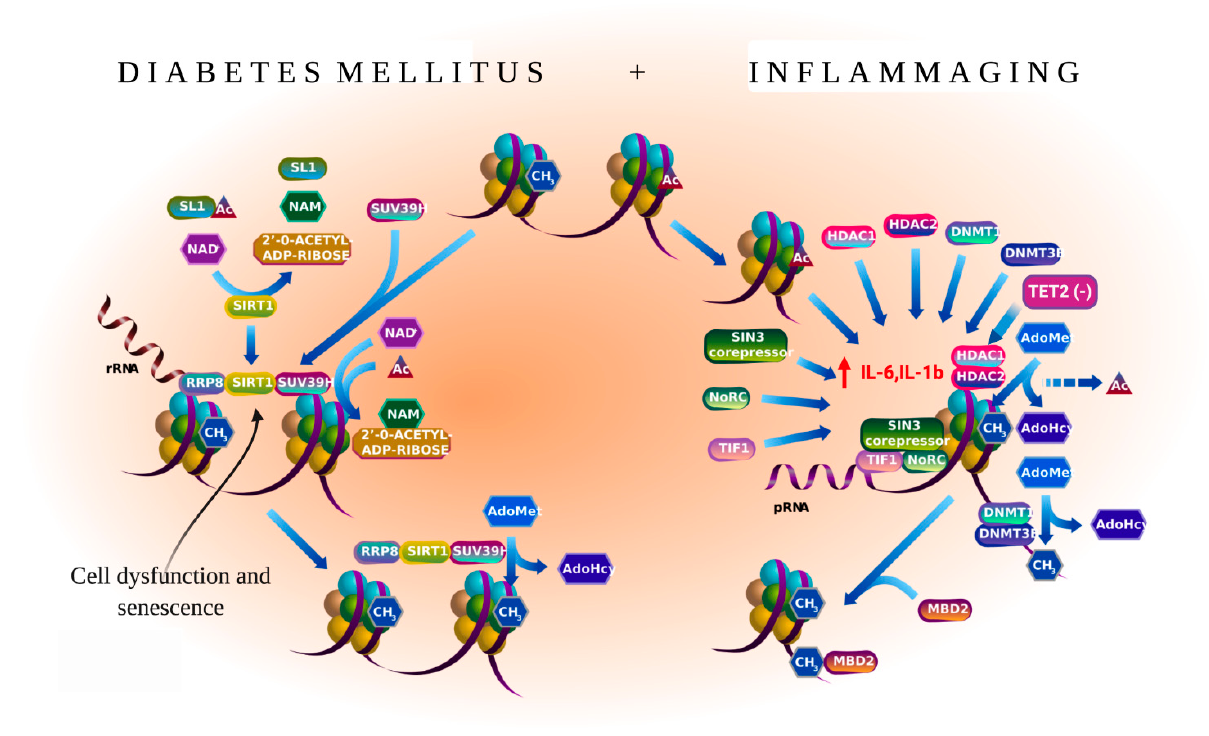
Figure 1. Negative epigenetic regulation of gene expression. The figure was reproduced from Reactome ver. 72 (URL.: https://reactome.org/PathwayBrowser/#/R-HSA-5250941, accessed on 18 January 2021. Stable ID: R-HAS-5250941. Abbreviations: NoRC, nucleolar remodeling complex.